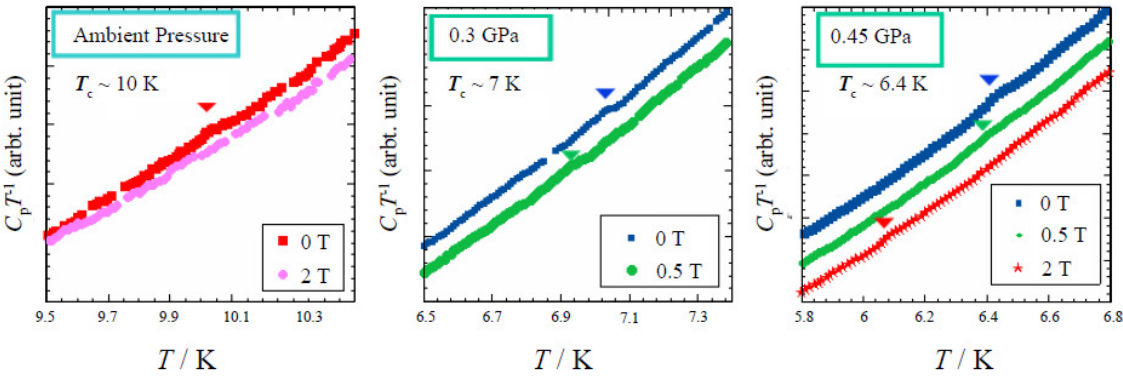
(BEDSe-TTF) ] Cu[N(CN) 0.90 0.10 2 2